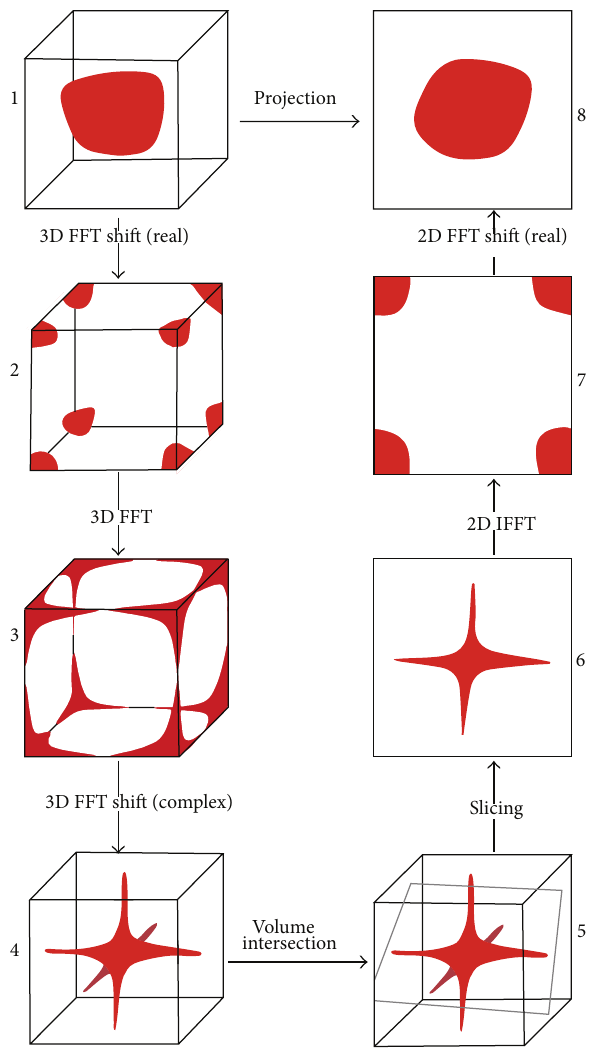
Figure 1: Graphical illustration of the FVR